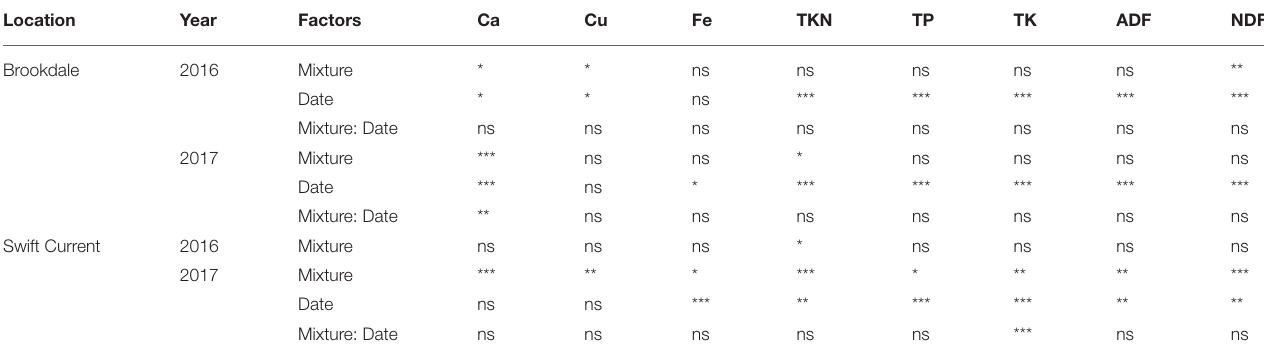
TABLE 2 | ANOVA results of the effect of cropping mixtures (monoculture, three, six, and nine spp.) and date of sampling (mid or late growing season) on forage quality and nutrition at the Swift Current and Brookdale research sites in 2016 and 2017.